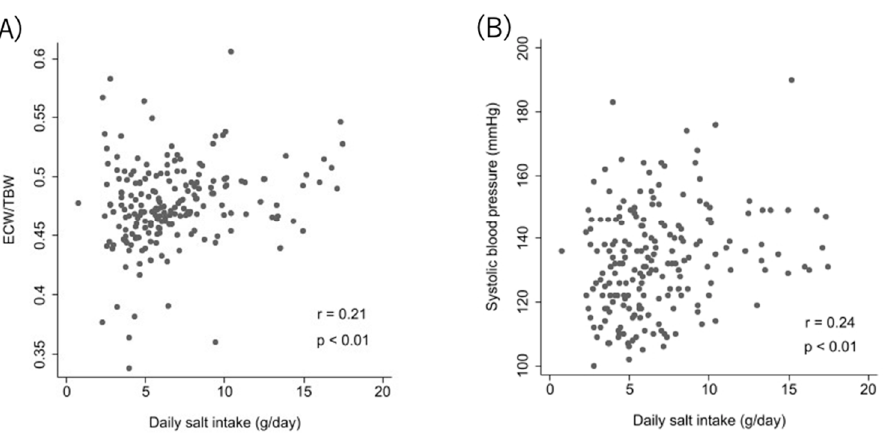
Figure 2. Correlation between DSI and ECW/TBW and systolic blood pressure. Relationship between relative DSI and ECW/TBW ( A ), and between DSI and systolic blood pressure ( B ).